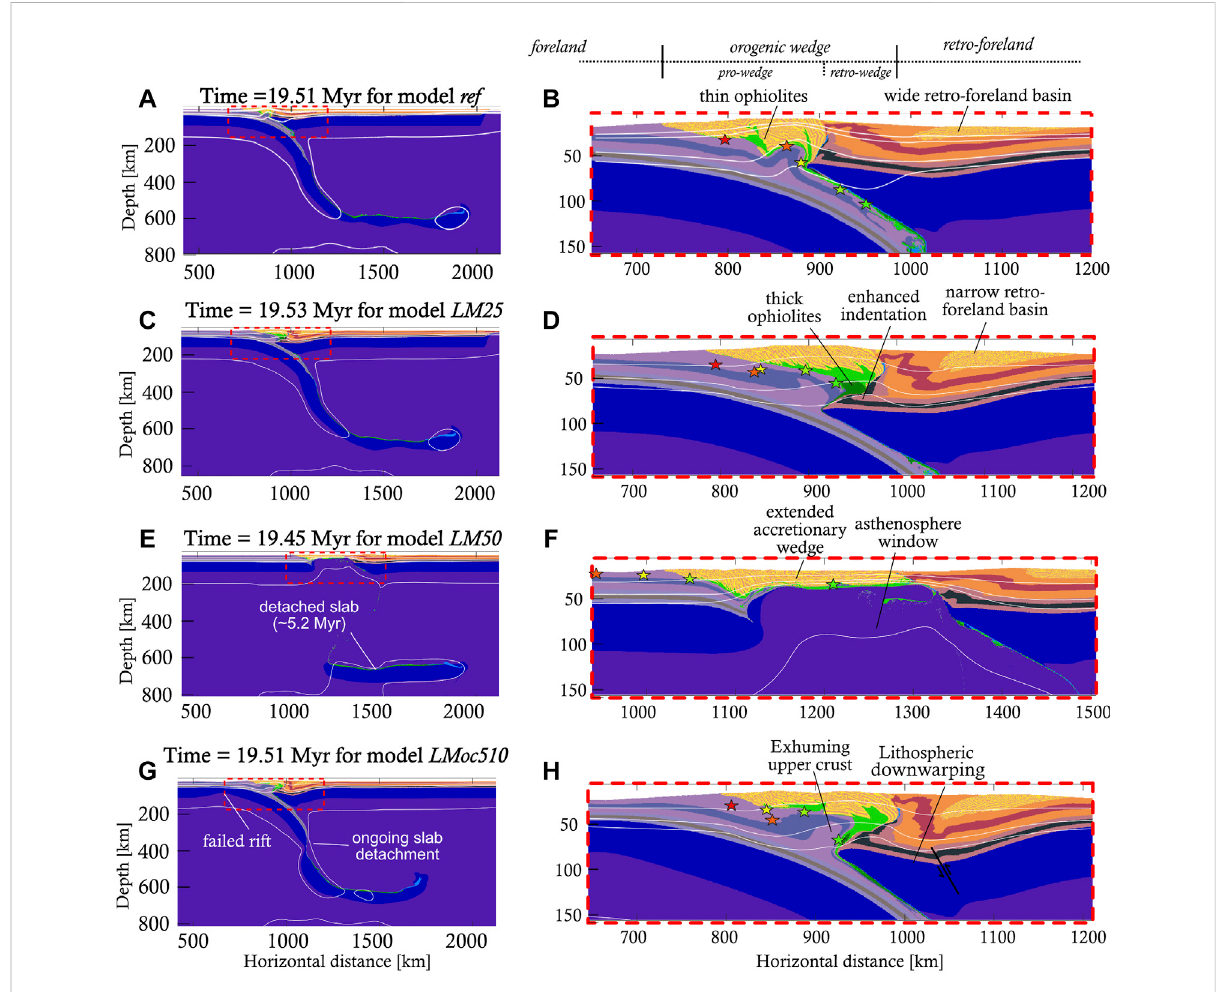
FIGURE 10 Inter-model comparison of the compositional evolution between models (A,B) ref , (C,D) LM25 , (E,F) LM50 , and (G,H) LMoc510 during stage 2 (Figure 1), illustrating the key role of lithospheric mantle frictional strength in subduction and collision dynamics. A very weak lithospheric mantle (model LM50 ) results in premature slab detachment and rifting, but not if combined with a slightly shorter ocean ( LMoc510